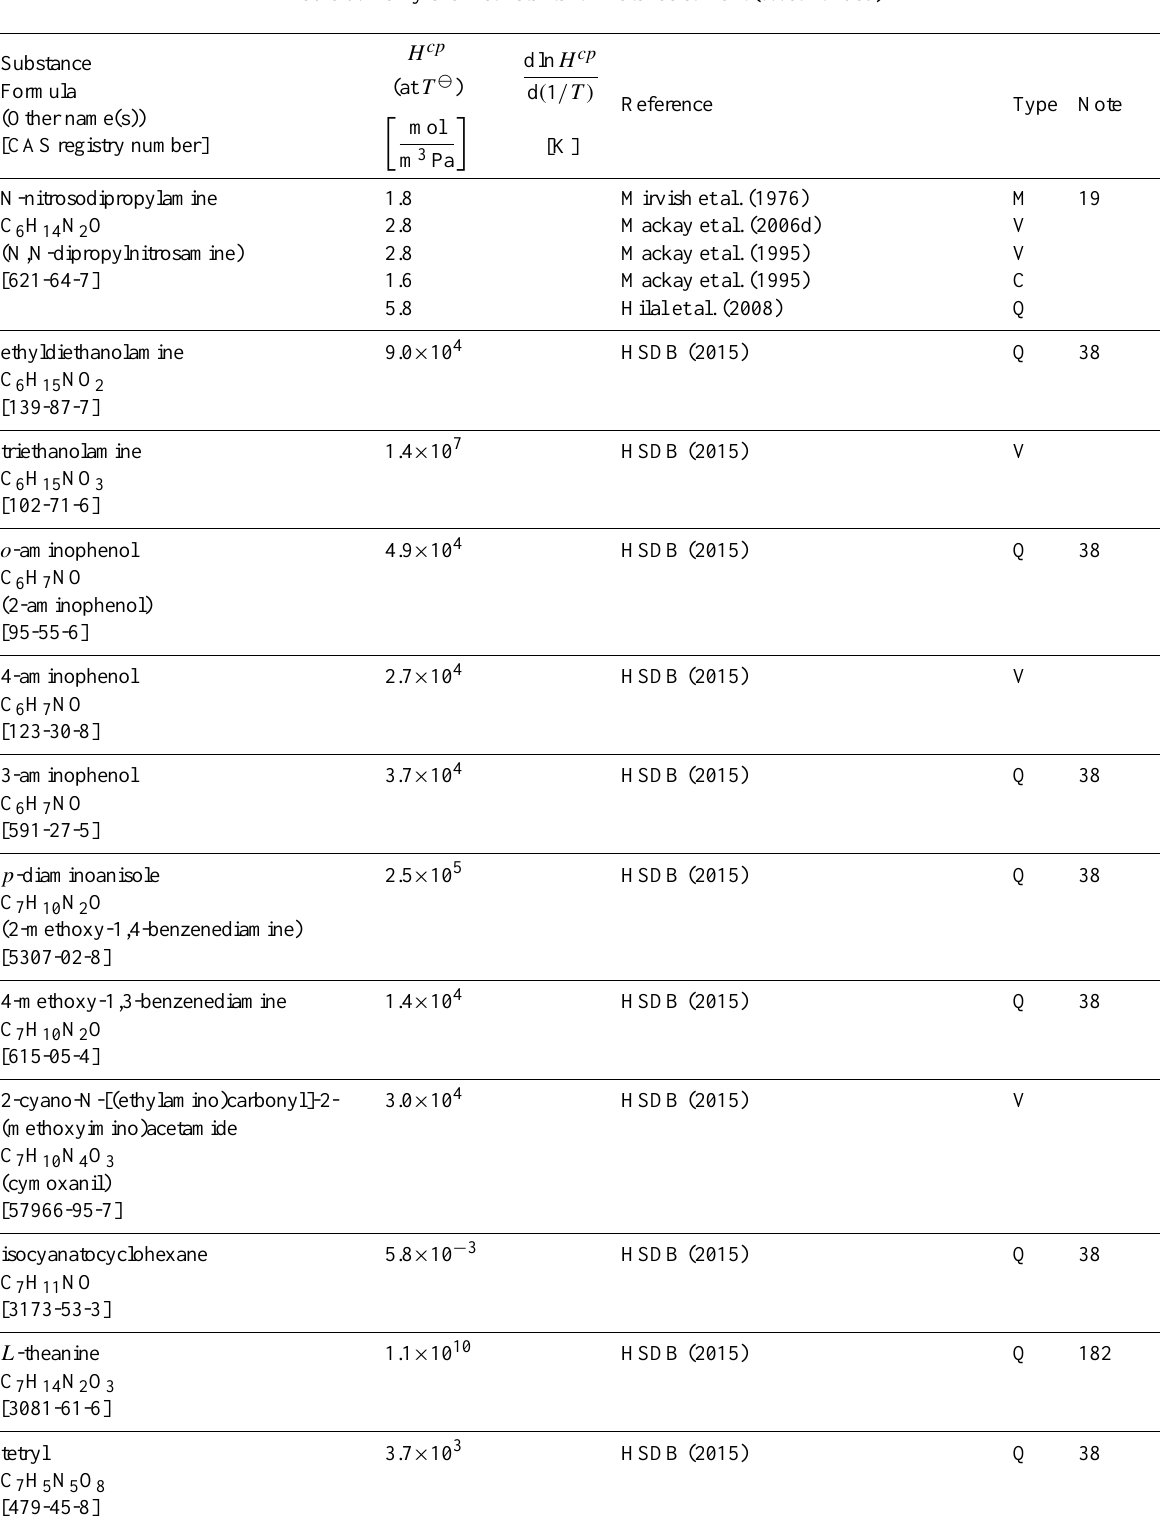
Table 6: Henry’s law constants for water as solvent